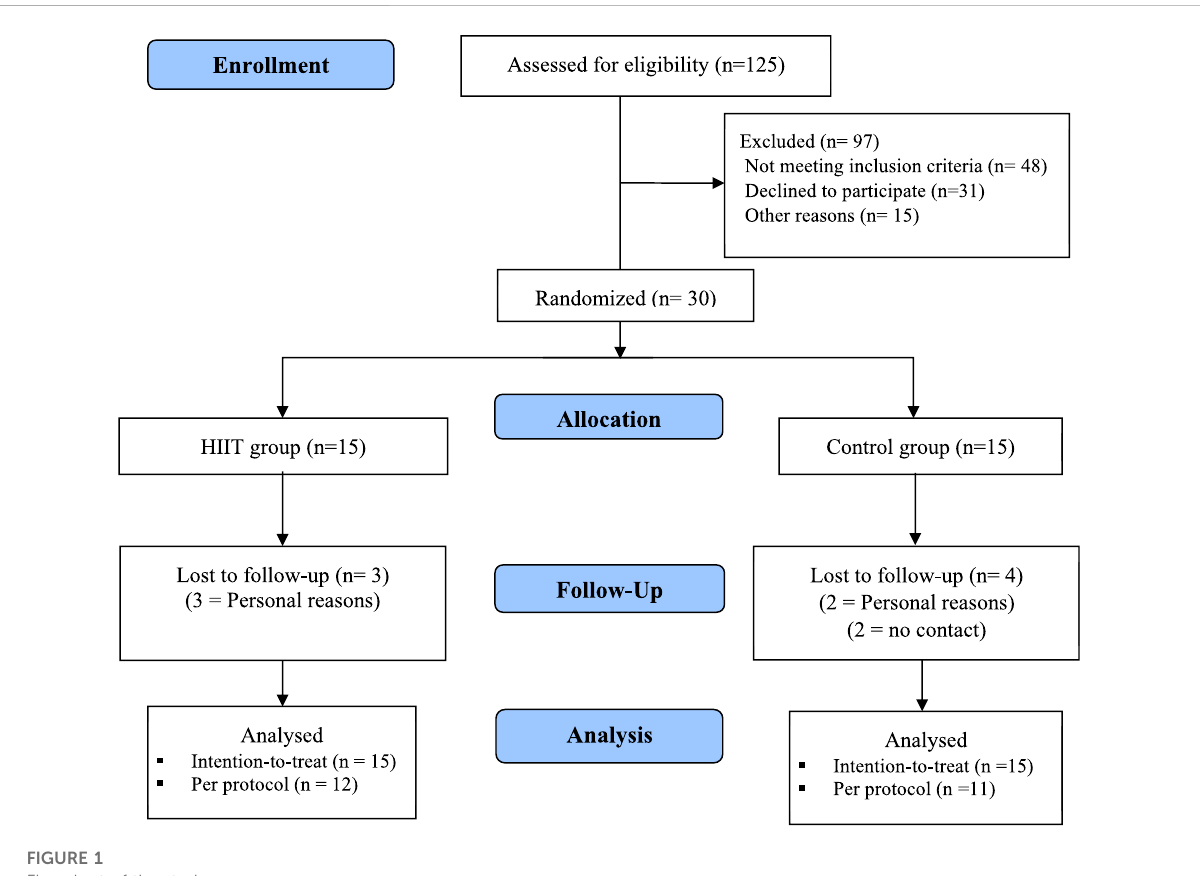
FIGURE 1 Flowchart of the